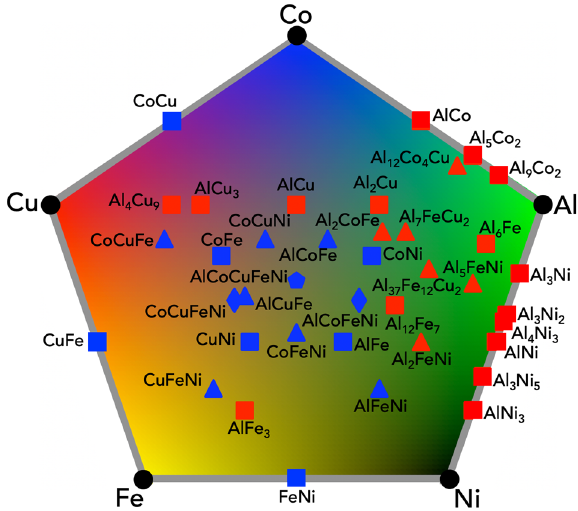
Fig. 2 Projected barycentric phase diagram. 4D phase diagram of the Al − Cu − Co − Ni − Fe system at 1500 K projected into a pentagon, where each vertex represents an element. Solid solutions are colored in blue while intermetallic phases are colored in red. A 2D point ’ s distance from each vertex is related to the composition corresponding to that point. Binary tie lines connect vertices, lying along edges of the polygon for adjacent elements and extending across the polygon for non-adjacent elements. Ternary compositions lie within a triangle connecting three elements, and quaternary compositions lie within a quadrilateral. Some positions in the pentagon correspond to multiple compositions, as the projection of the 5D space into 2D leads to the collapse of multiple 5D points into the same 2D